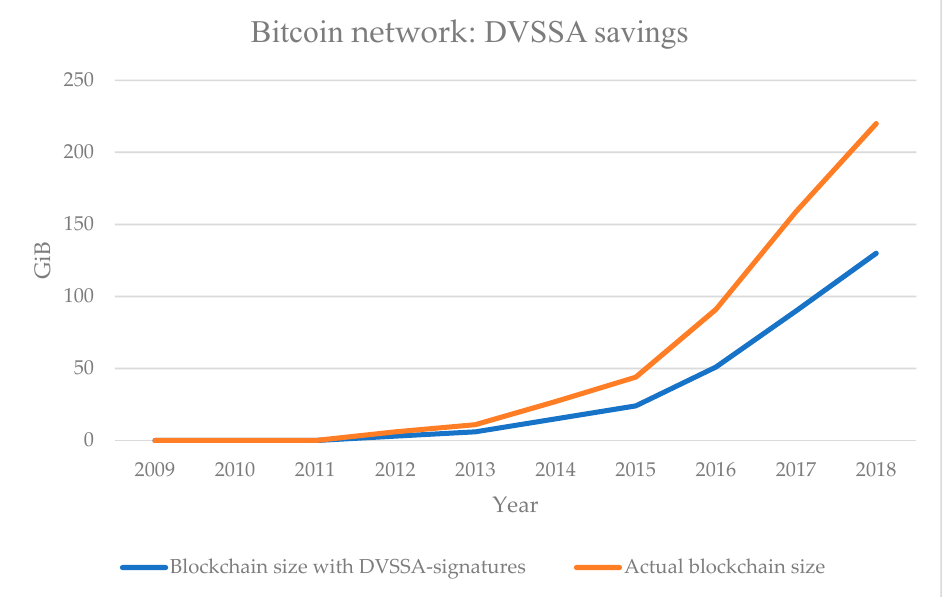
Figure 6. Energy consumption on communications with regard to the number of users.